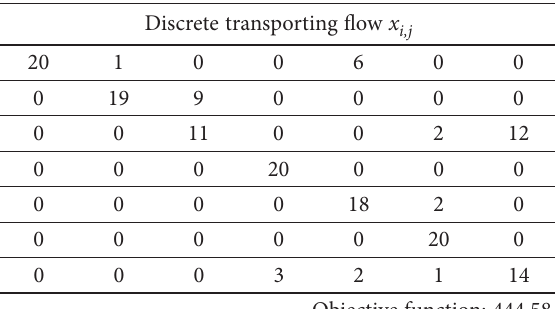
Table 14. Best obtained discrete solution for the 7×7